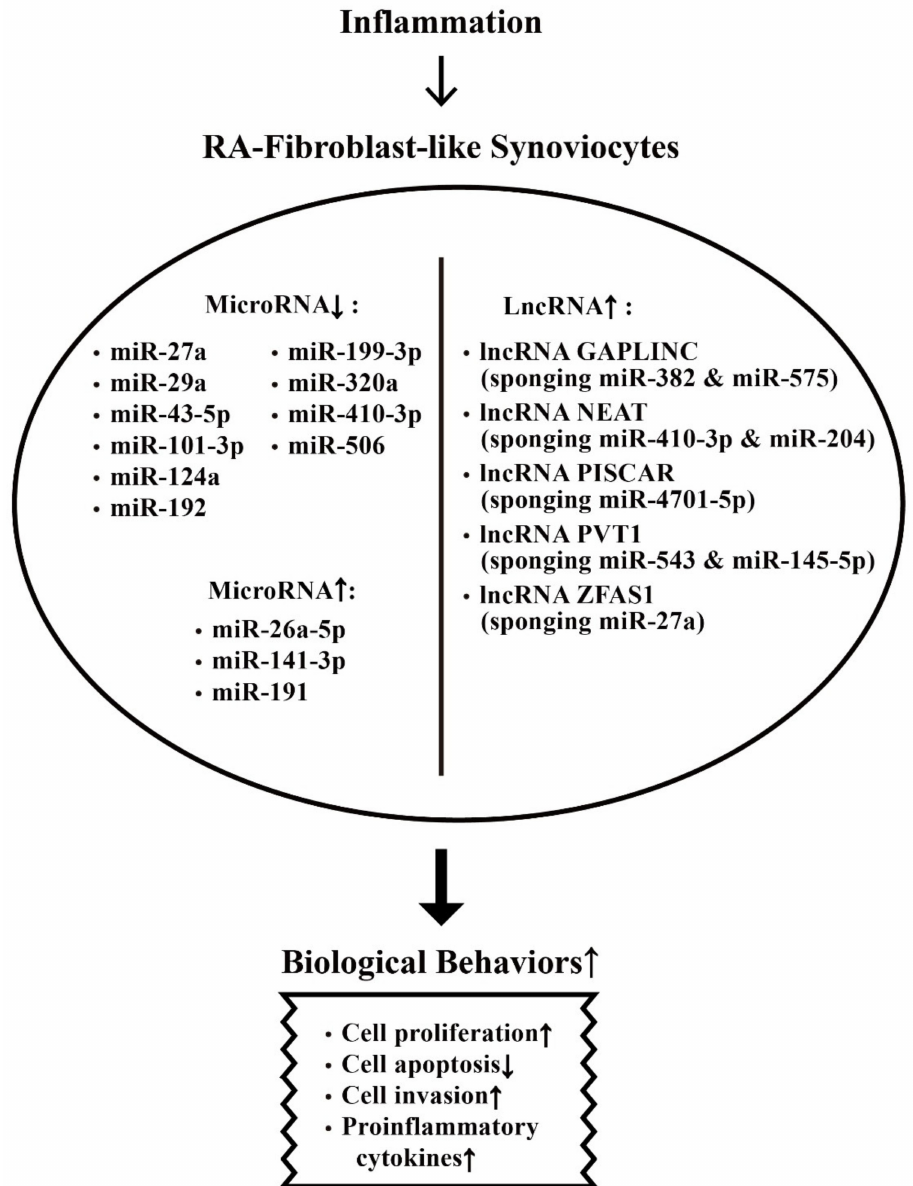
Figure 6. The effects of inflammation on ncRNA expressions and on the biological behavioral changes of rheumatoid arthritis fibroblast-like synoviocytes (RA-FLSs) that are relevant to RA pathogenesis. The biological behavioral changes of RA-FLSs include increased cell proliferation, decreased cell apoptosis, enhanced cell invasion, and augmenting proinflammatory cytokine productions. ↑ : Increase, ↓ :